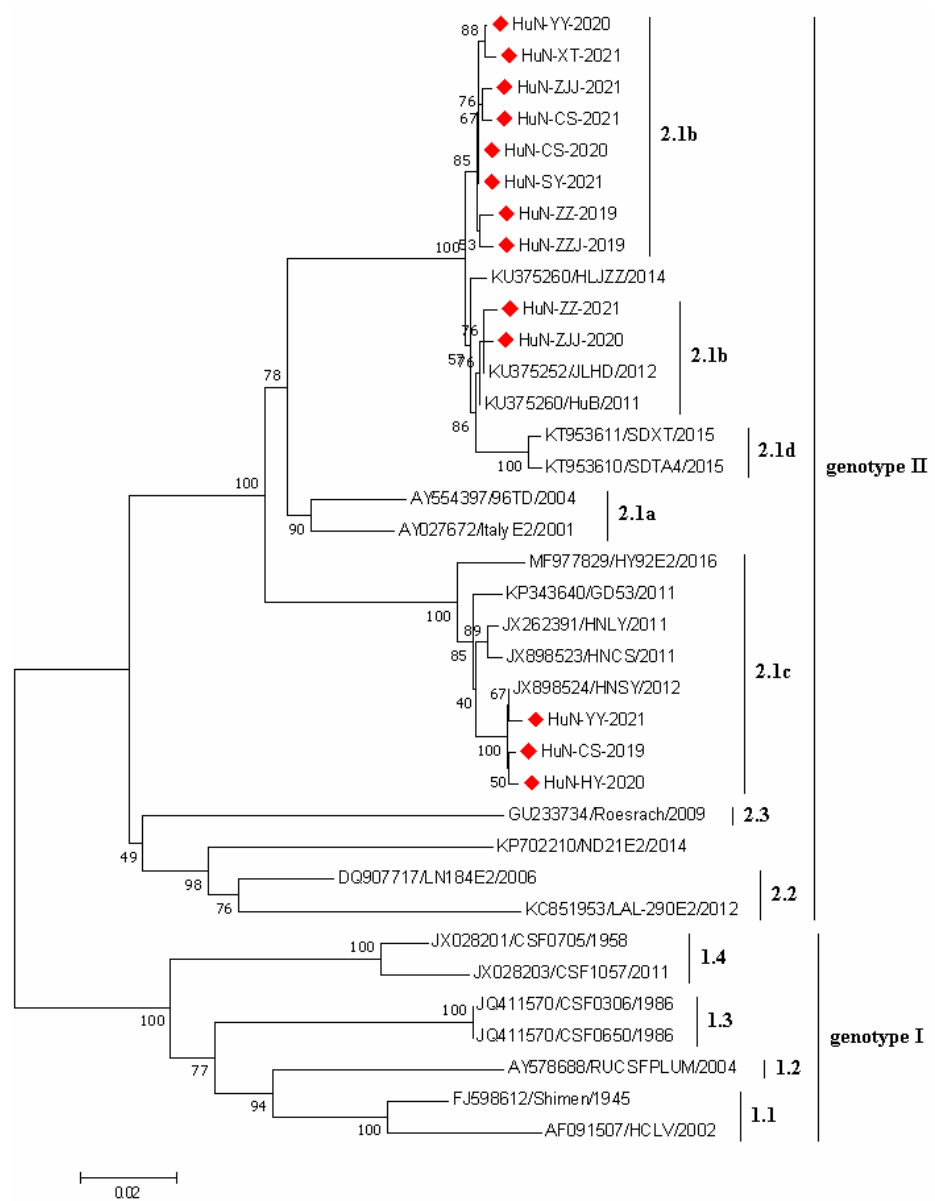
Figure 3. Phylogenetic tree based on E2 gene sequences of 13 CSFV strains identified in this study and other reference strains generated by the neighbor-joining method in MEGA 7.0 software, with 1000 bootstrap support. The red prismatics represented these newly identified CSFV strains.